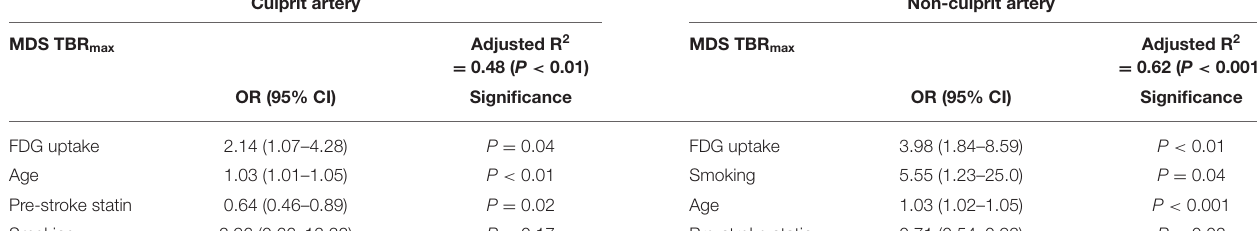
TABLE 3 | Multiple logistic regression for moderate/severe leukoaraiosis severity for focal (MDS) and whole vessel (WV) FDG uptake in culprit and non-culprit carotid arteries.